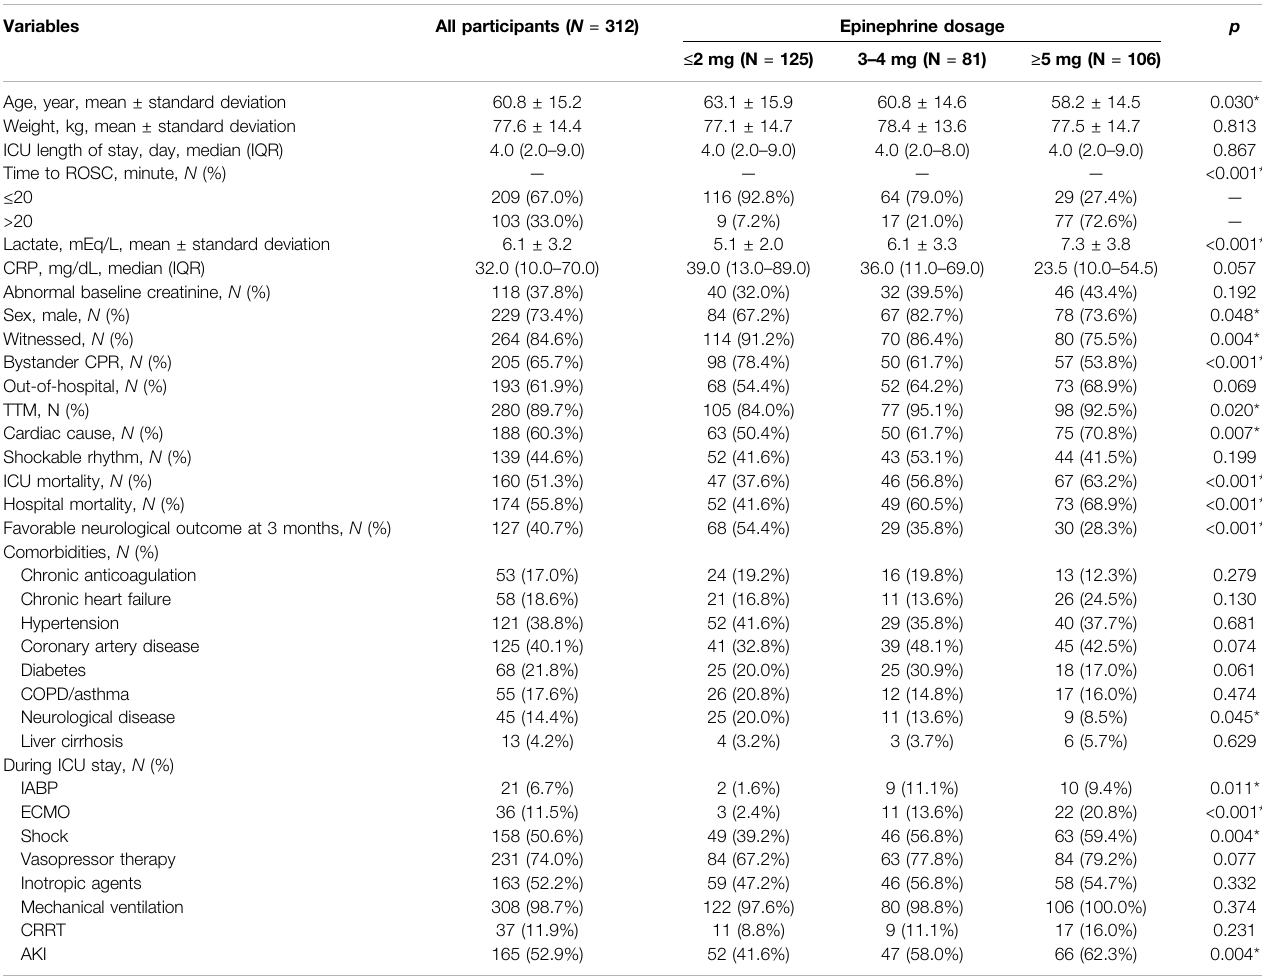
TABLE 1 | Characteristics of patients with different epinephrine dosages.